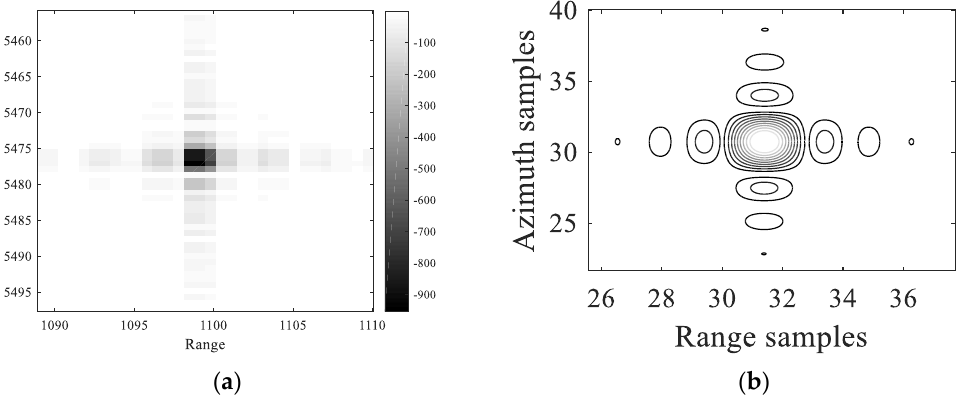
Figure 10. Refocusing results of target 1. ( a ) SAR image of target 1; ( b ) Contour plot of target 1.